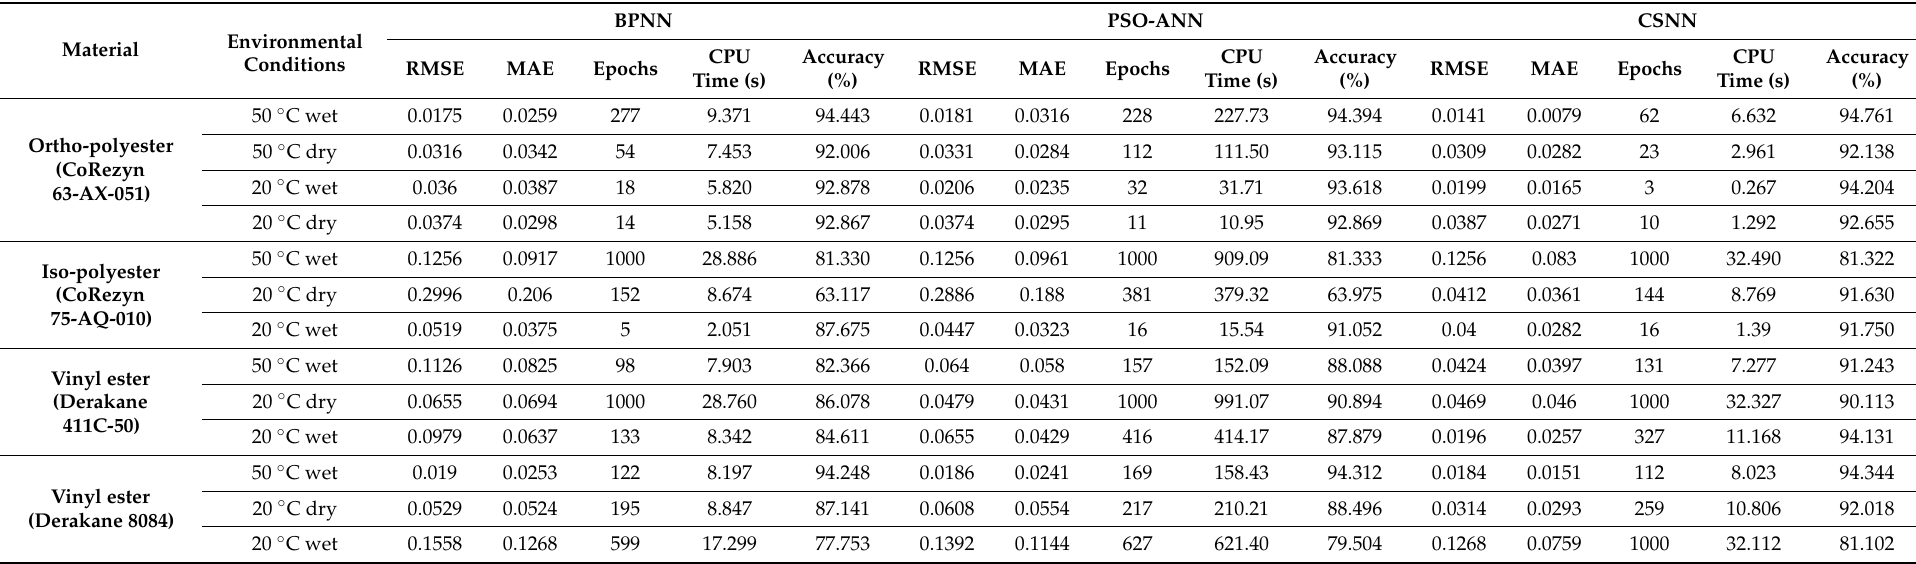
Table 5. RMSE, MAE, epochs, CPU time and prediction accuracies for all materials and